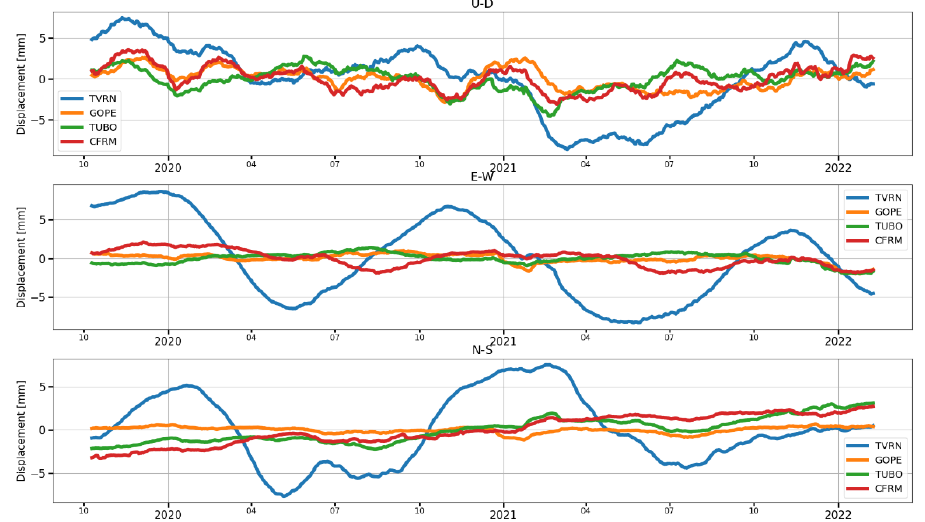
Figure 10. Displacements at GNSS stations in U – D (top), E – W (middle), and N – S (bottom) compo- nents. Stations are TVRN (blue), GOPE (orange), TUBO (green), and CFRM (red). Original values were smoothed by the 35-day window.